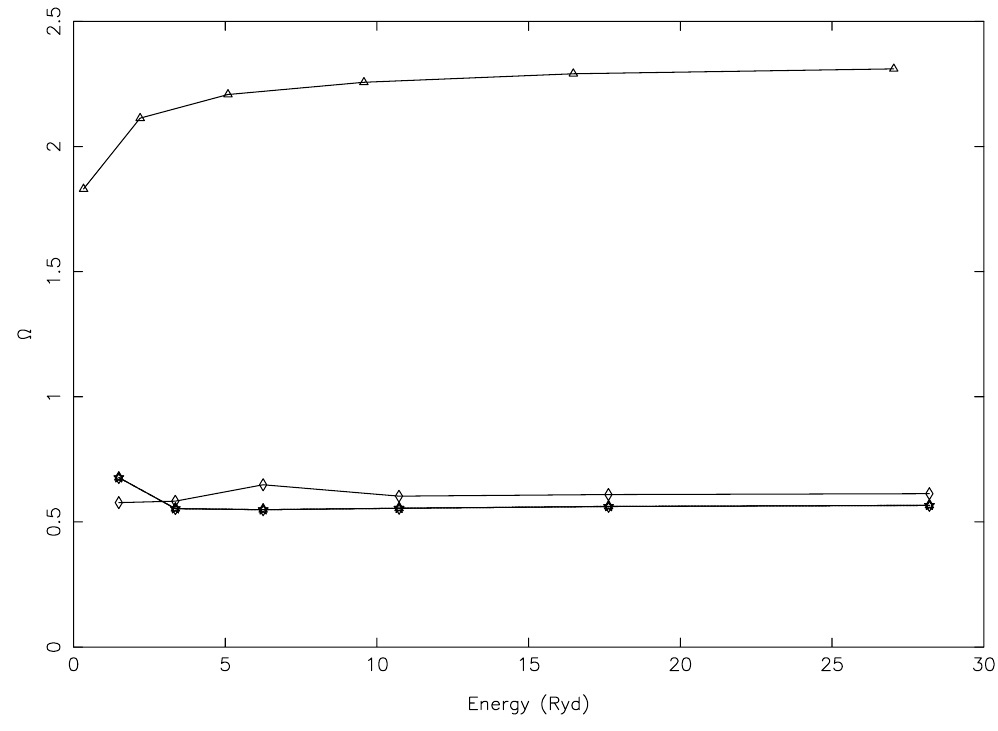
Figure 7. Our calculated values of Ω with FAC for the 4–5 (triangles: 3p 2 1 D 2 –3p 2 1 S 0 ), 20–25 (diamonds: 3p3d 3 P o –3p3d 3 D o ), and 20–27 (stars: 3p3d 3 P o 1 1